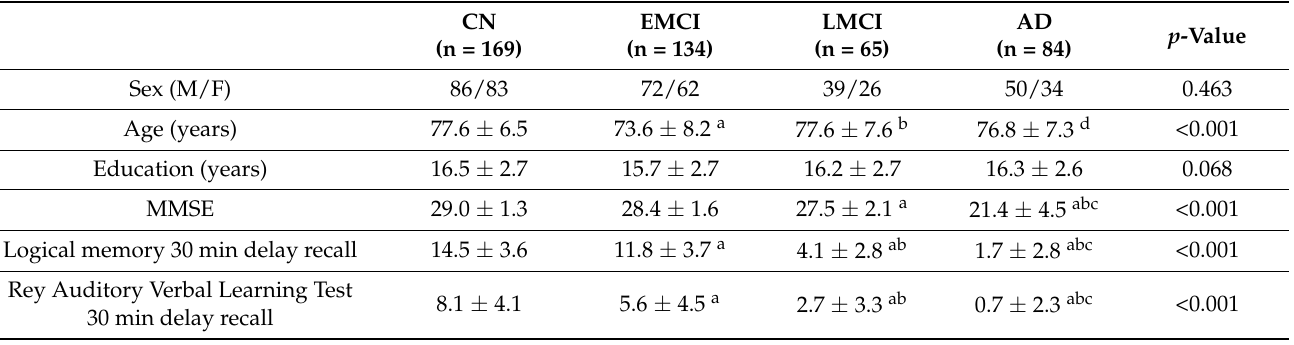
Table 1. Characteristics of the